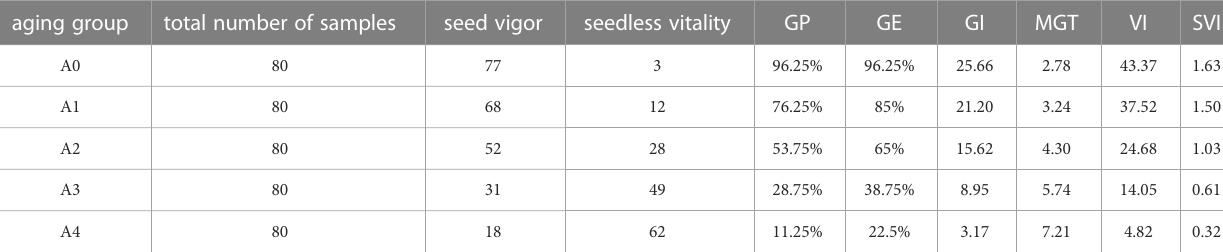
TABLE 1 Seed vigor index test result